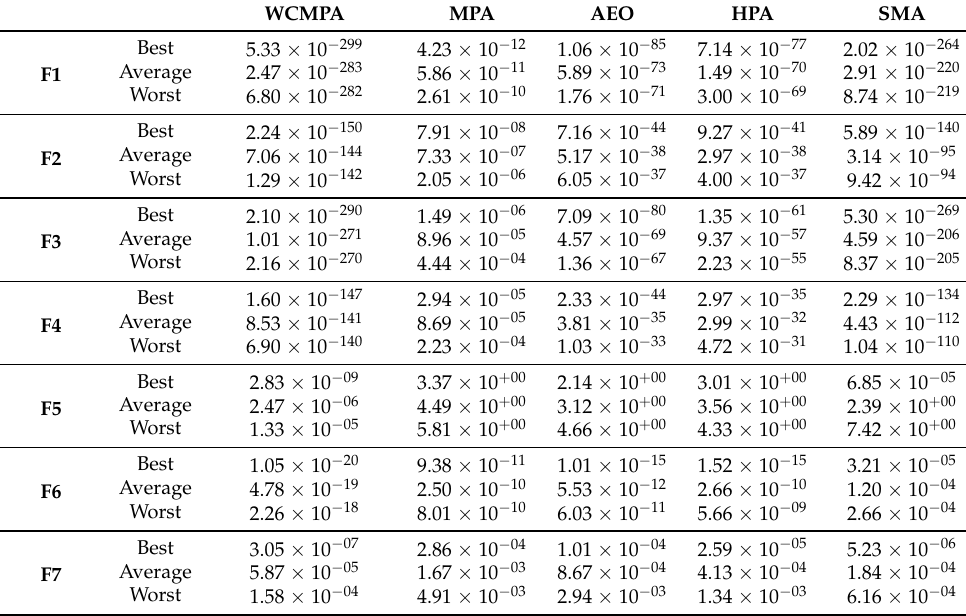
Table 2. Parametric test values for unimodal benchmark